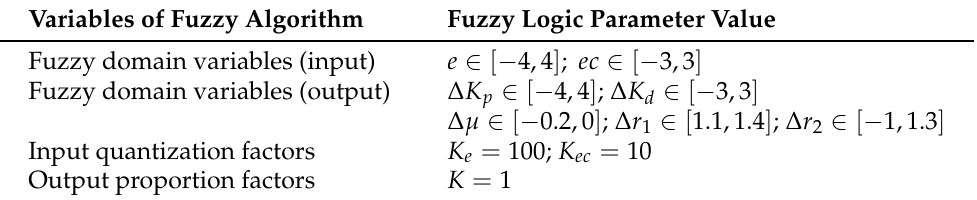
Table 3. Fuzzy logic control parameters.